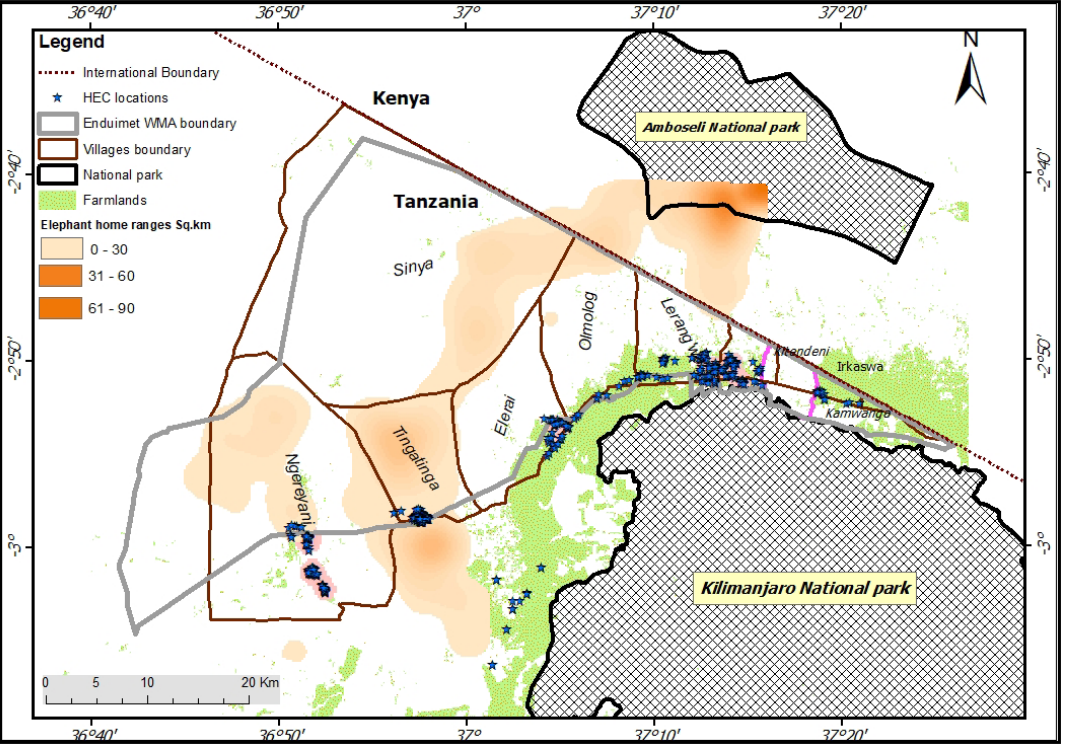
Figure 4. Home ranges for three collared male elephants ( n = 52,488) in the EWMA and close farmlands adjacent to the southern part of EWMA from July 2019 to September 2020 calculated using Kernel Density Estimation (KDE).